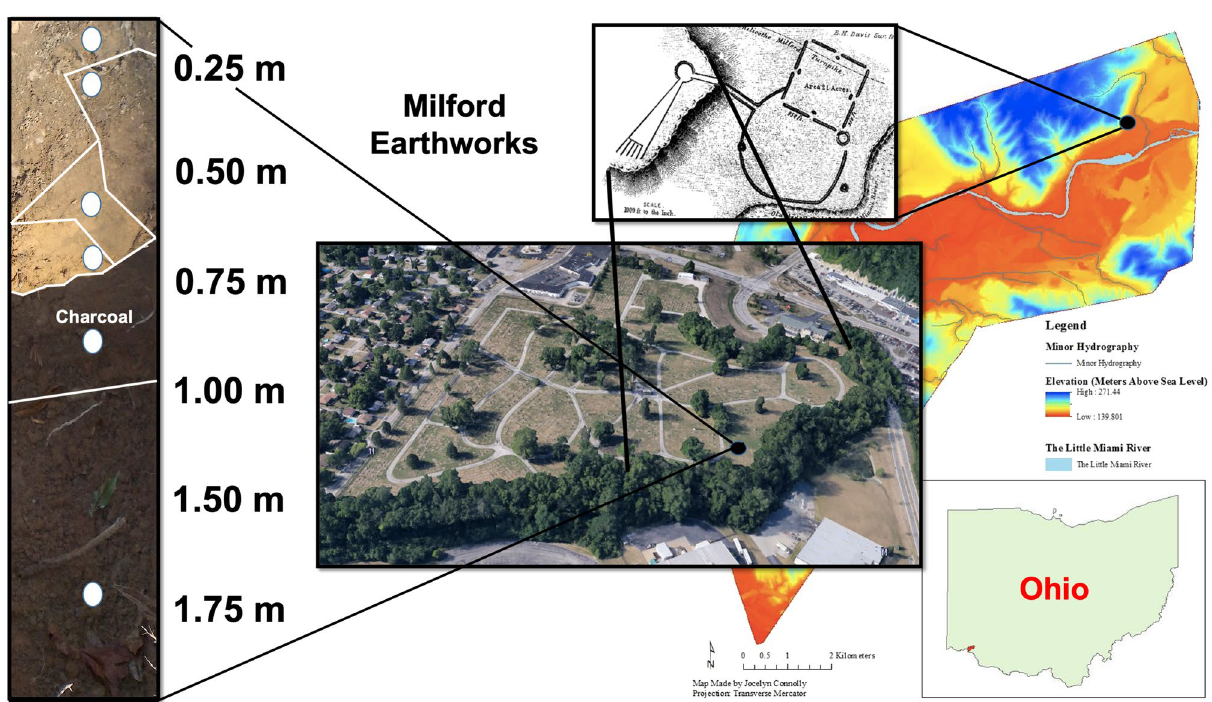
Figure 7. The location, stratigraphy, and sample sites (white circles) of the Milford Earthwork site, Clermont County, Ohio. Kenneth Barnett Tankersley used Microsoft PowerPoint for Mac Version 16.41 (www. micro soft. com) to create this figure. The GIS map was produced in ESRI ArcGIS 10.3.1 software (www. esri.